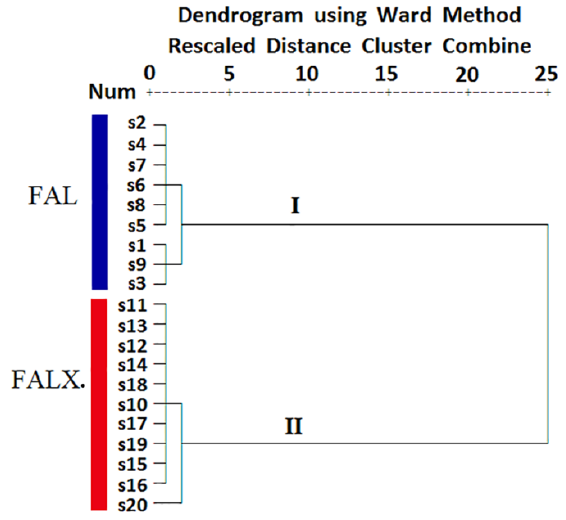
Figure 4. Hierarchical cluster analysis (HCA) of 20 FA samples from two species using Ward’s method based on the Euclidean distance.